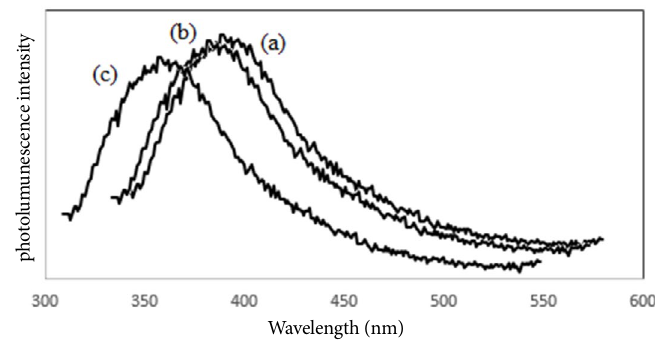
Fig. 5. Photoluminescence spectra for Au-Cu nanoparticles: (a) 10%, (b) 25%, (c) 50%